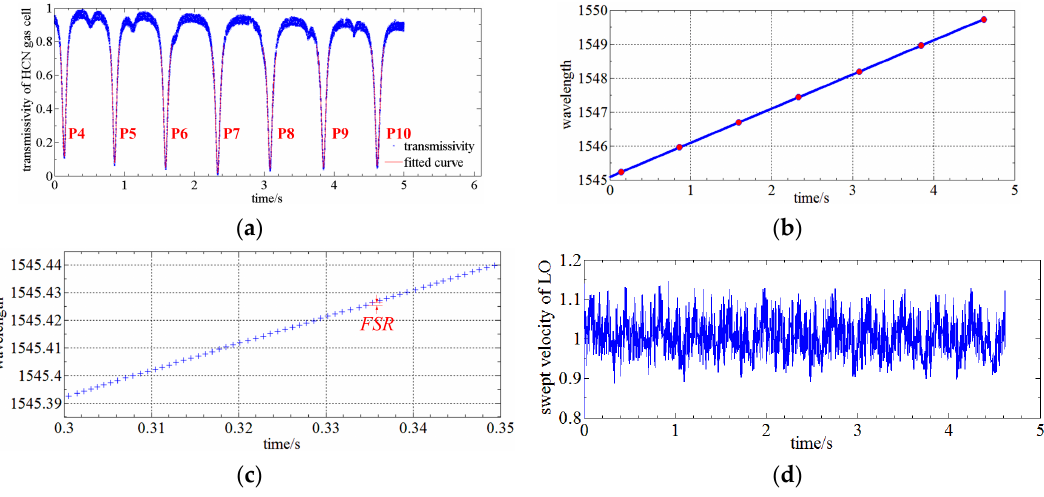
Figure 11. ( a ) Signal processing of HCN; ( b ) Signal processing of FP; ( c ) Detailed view of ( b ); ( d ) Sweep velocity of LO at nominal velocity of 1